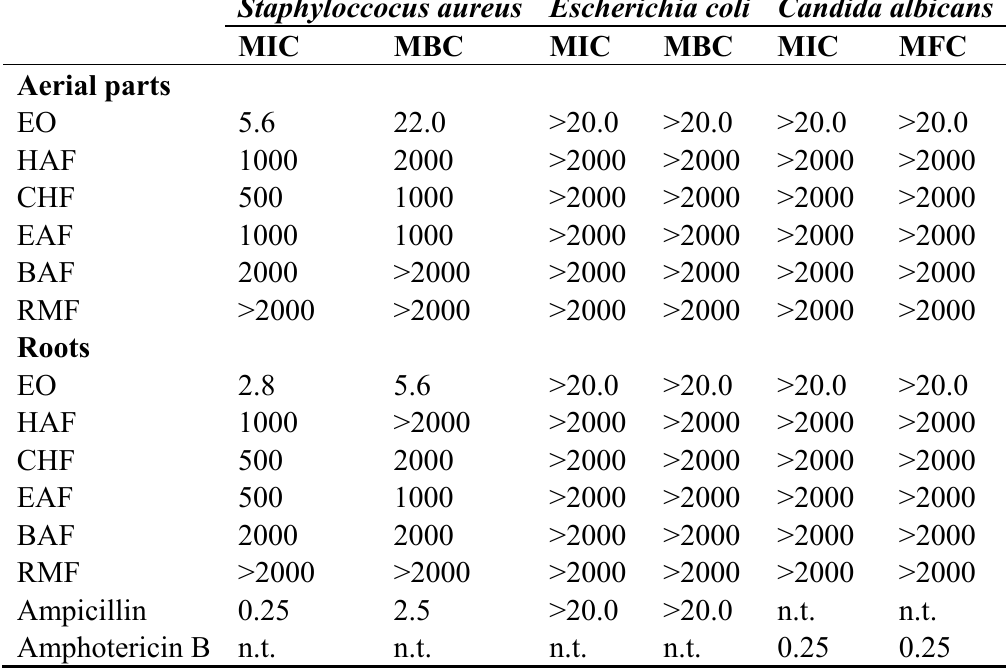
Table 3. Antimicrobial activity (MIC, MBC/MFC) of essential oils and crude extracts from aerial parts and roots of E. macrorrhiza for Staphyloccocus aureus , Escherichia coli and Canidia albicans strains. MIC and MBC/MFC were determined by macrodilution method and expressed in μ